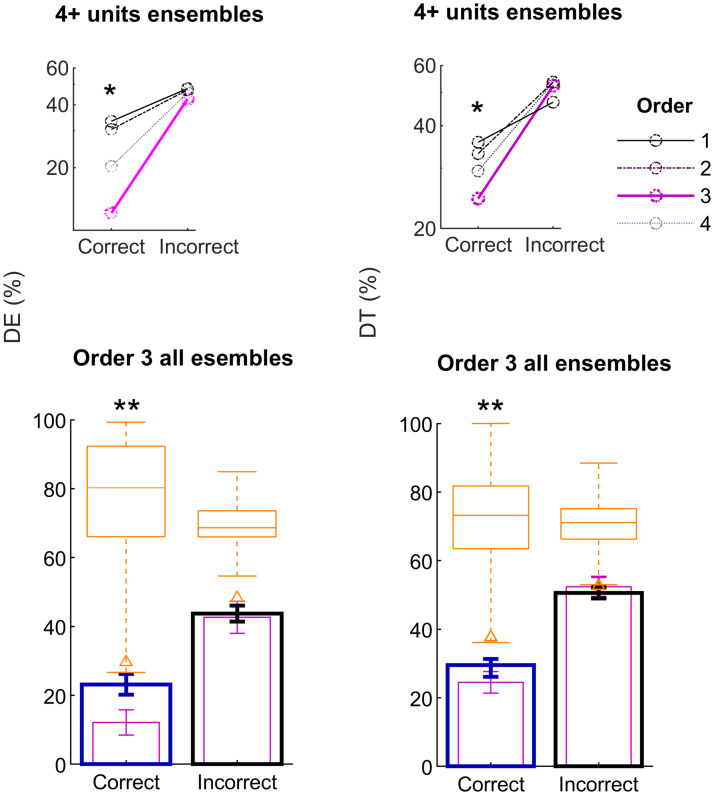
Successful choices are optimally encoded in up to three-way orchestrated interactions.Decoding performance indexes for correct-choice outcomes (blue, large panels) versus the average through incorrect-choice outcomes (black, large panels), and for all the ensembles recorded. The decoder operates in an optimal state-space, incorporating up to triplet interactions between units (large panels). As in Fig 3B, a kernel-discriminant was used to compute the causally cross-validated value of the decoding error (DE, left) and the trajectory divergence index (DT, right) for each ensemble and choice type. Error bars are SEM, *p < 0.05, **p < 0.001. Orange boxplots show the quartiles, whiskers indicate outliers and triangle markers the 1% percentile, permutation test as in previous figures. Some examples of individual ensembles are shown in S2 Fig. Insets (top small panels) show the decoding performance indexes per behavioral response category, calculated in a range of state spaces spanning from the multiple single-unit activity space (order 1) to state spaces incorporating up to four-way interactions (order 4). For establishing a fair comparison across orders, only ensembles consisting of four or more units are considered in the inset plots and in forthcoming analyses. Results for the optimal state-space order (order 3, magenta) are also shown in the large panels below for comparison.